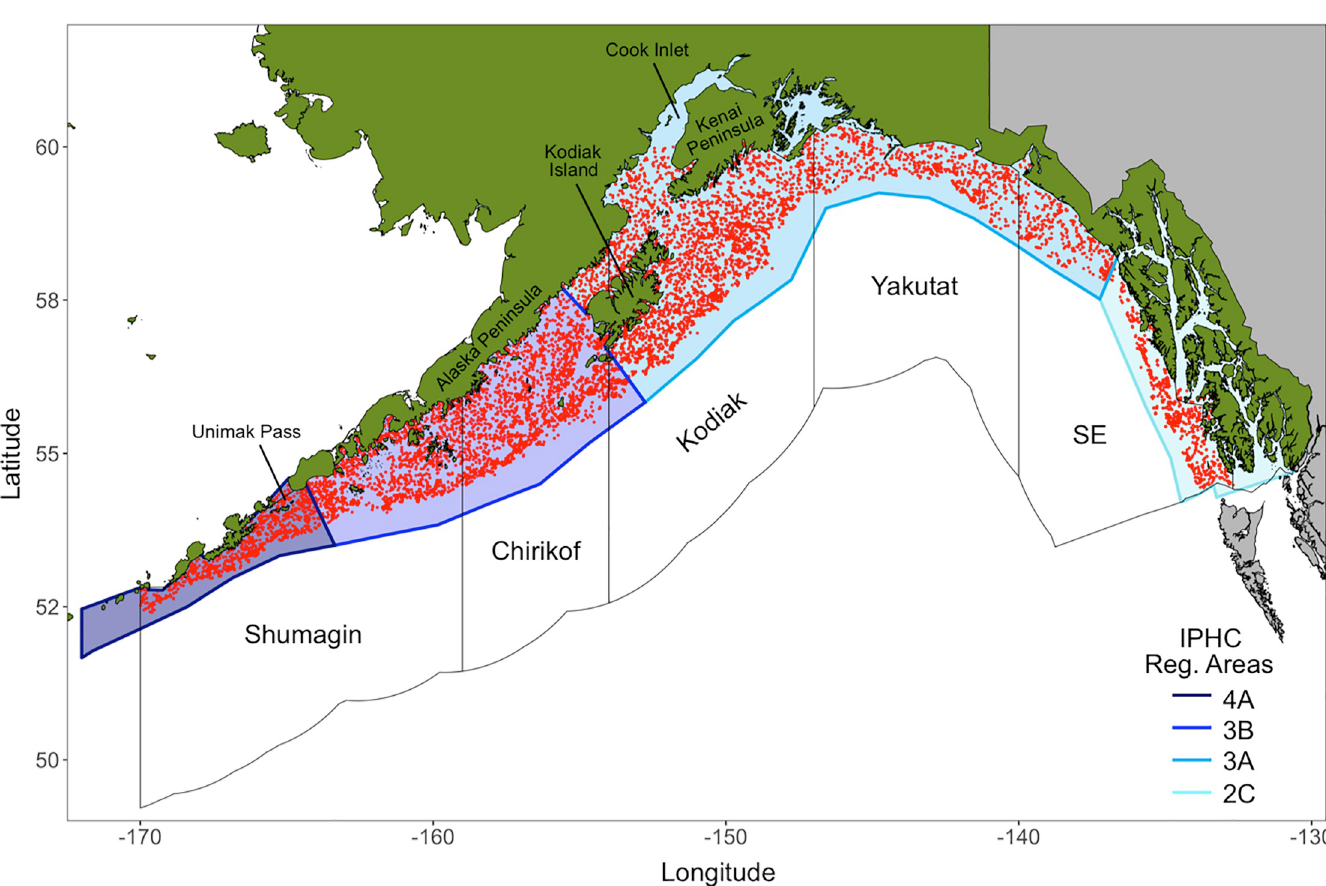
Fig 1. Map of bottom trawl survey area (Alaska Fisheries Science Center, NOAA; 1990 to 2017). Red dots indicate individual tow locations throughout the Gulf of Alaska. Unfilled polygons outlined in black denote Shumagin, Chirikof, Kodiak, Yakutat, and Southeastern (SE) statistical areas defined by International North Pacific Fisheries Commission (INPFC). Blue-shaded polygons illustrate International Pacific Halibut Commission (IPHC) regulatory areas 4A, 3B, 3A, and 2C.